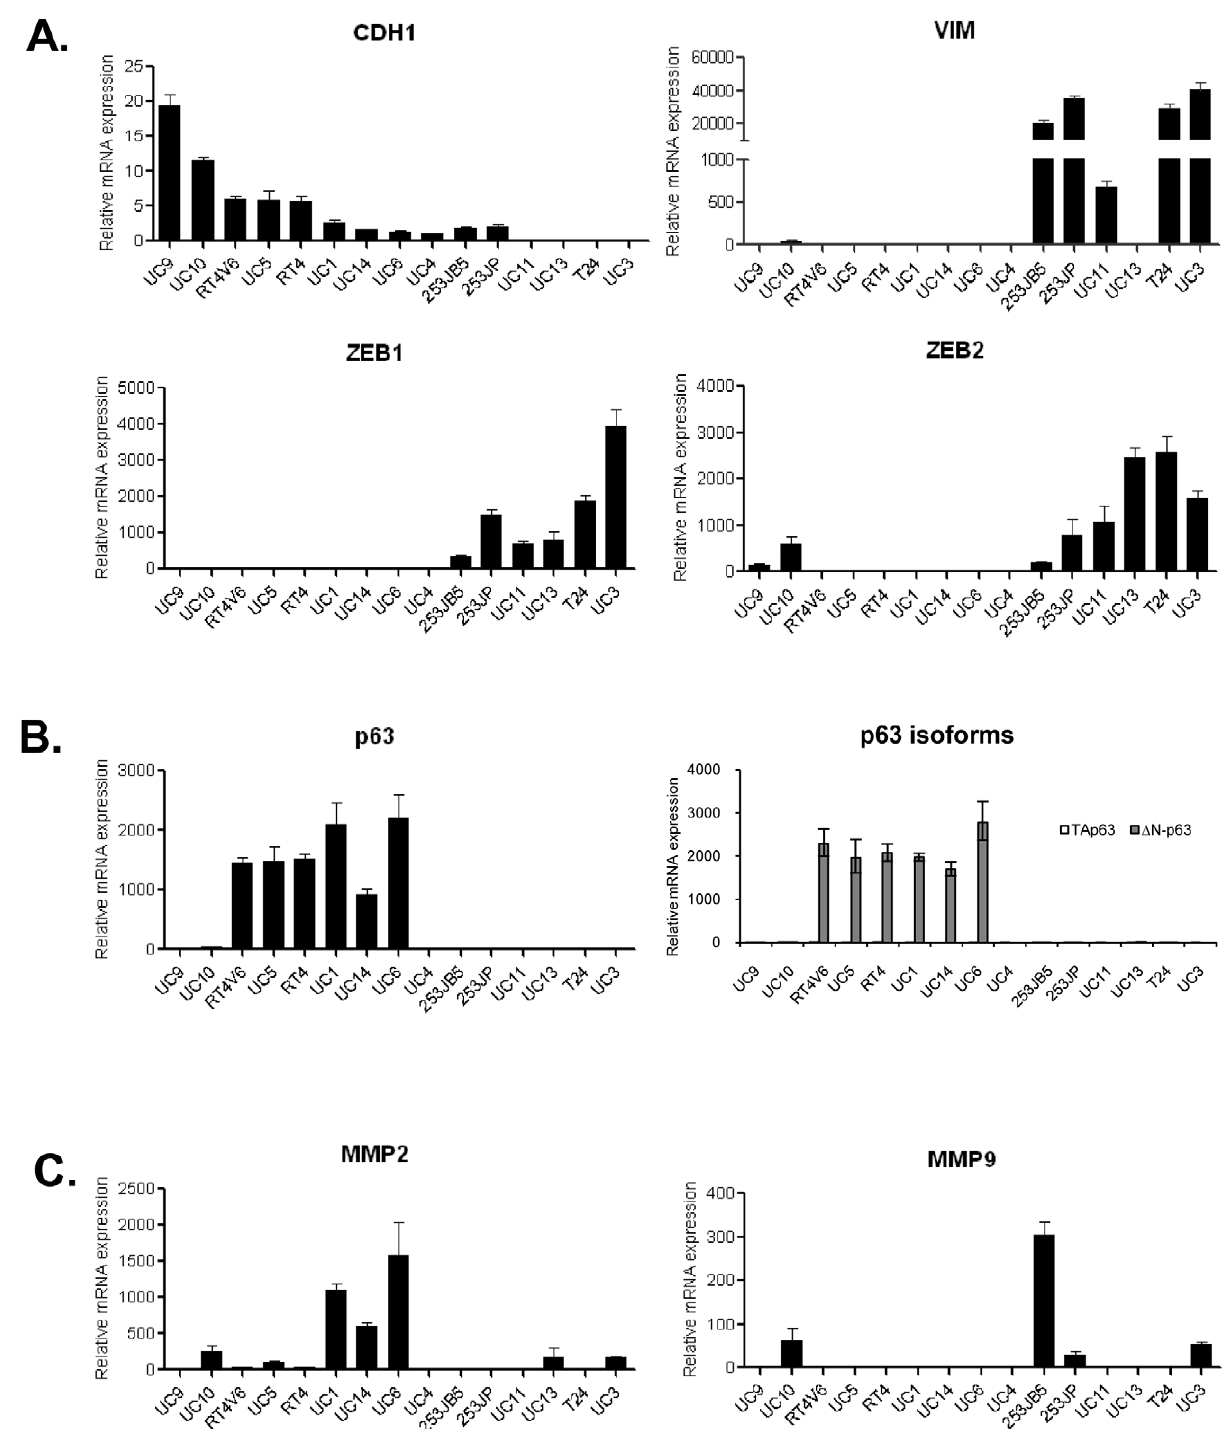
Figure 2. Differential expression of EMT markers in bladder cancer cell lines. (A) mRNA expression of E-cadherin, Zeb-1, Zeb-2 and vimentin were measured by quantitative real-time PCR. An inverse correlation between E-cadherin and Zeb-1/Zeb2 was observed across the cell lines. (B) mRNA expression of total p63, TAp63 and D N-p63 isoforms were measured by isoform specific primers. (C) Relative mRNA expression of MMP2 and MMP9 in bladder cancer cells. Data shown are mean 6 SEM from triplicate samples. doi:10.1371/journal.pone.0030206.g002 tumors as a group more consistently expressed E-cadherin and p63 was the major isoform of p63 present in primary tumor tissue p63 [3,4,18–23] than did muscle-invasive tumors (p-val- (Figure 3C). Conversely, muscle-invasive tumors more frequently ue , 0.0001, Figure S1A). Similarly to our cell line data, D N- expressed the mesenchymal markers (Zeb-1, Zeb-2, vimentin)